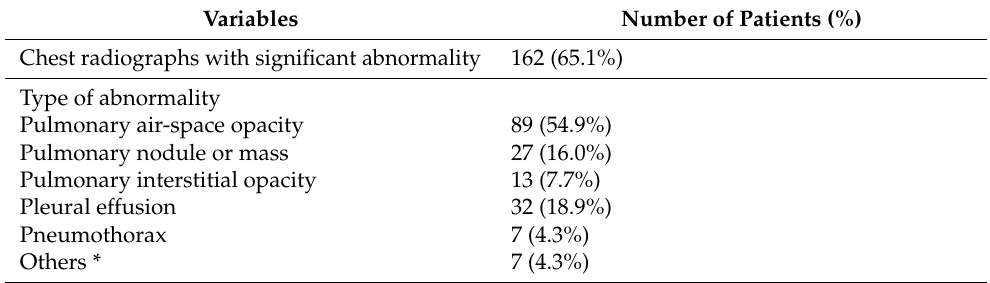
Table 2. Radiographic findings of